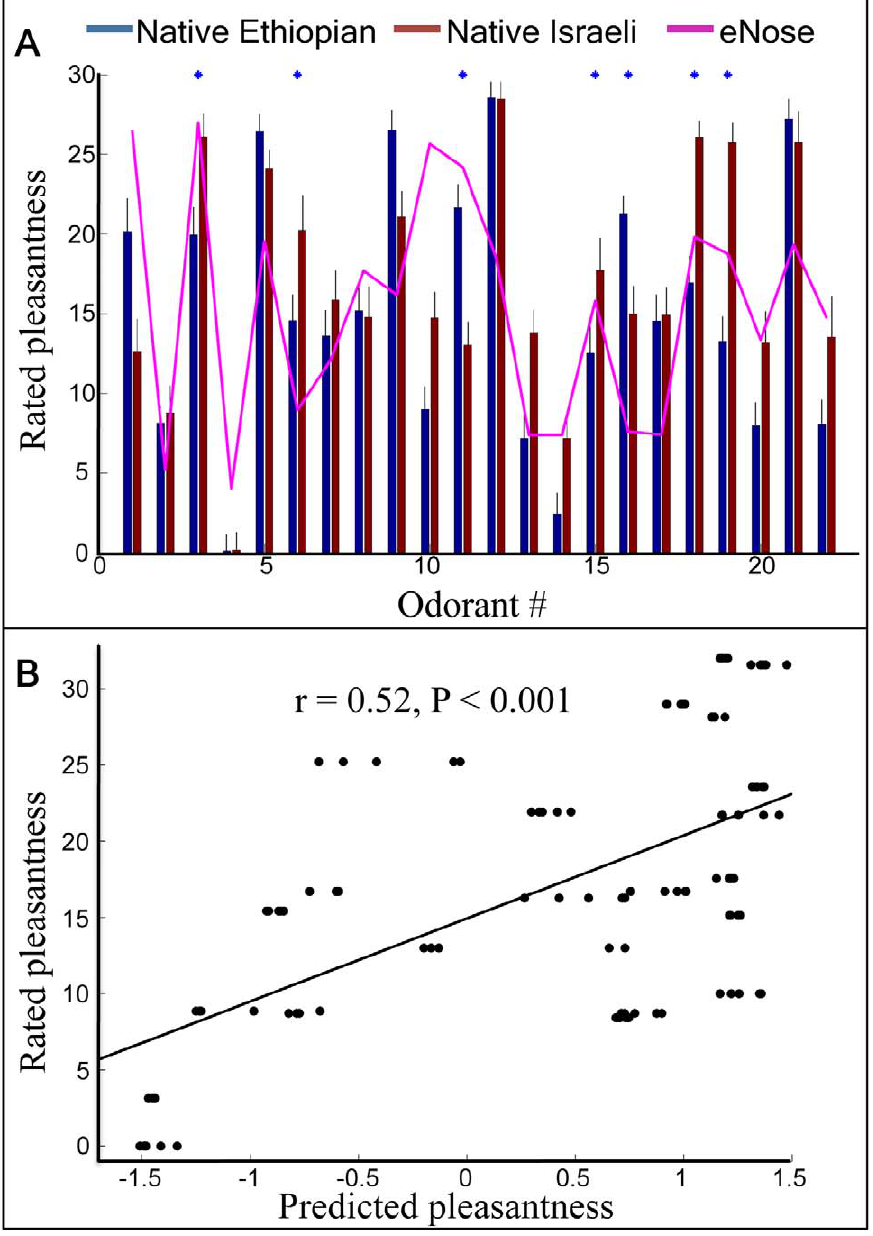
Figure 5. Cross-cultural validation. A. Odorant-specific pleasantness ratings for native Ethiopians (blue), native Israelis (brown), and eNose (pink). The blue stars on the upper x axis denote the 7 odorants where native Ethiopians and native Israelis significantly differed in their pleasantness ratings. Note that for odors # 6 # 18 and # 19 the pink line (eNose) is in fact closer to the native Ethiopians than to the native Israelis even though the eNose was tuned on a separate group of native Israelis. B. The correlation between the eNose pleasantness prediction values of 22 odorant mixtures (essential oils) and the values obtained from native Ethiopians. Each dot represents an eNose measurement (many dots overlay). Comparing Figure 2a to 5b reveals that native Israeli participants rated more at the middle of the VAS scale and native Ethiopians rated more at the scale extremes.